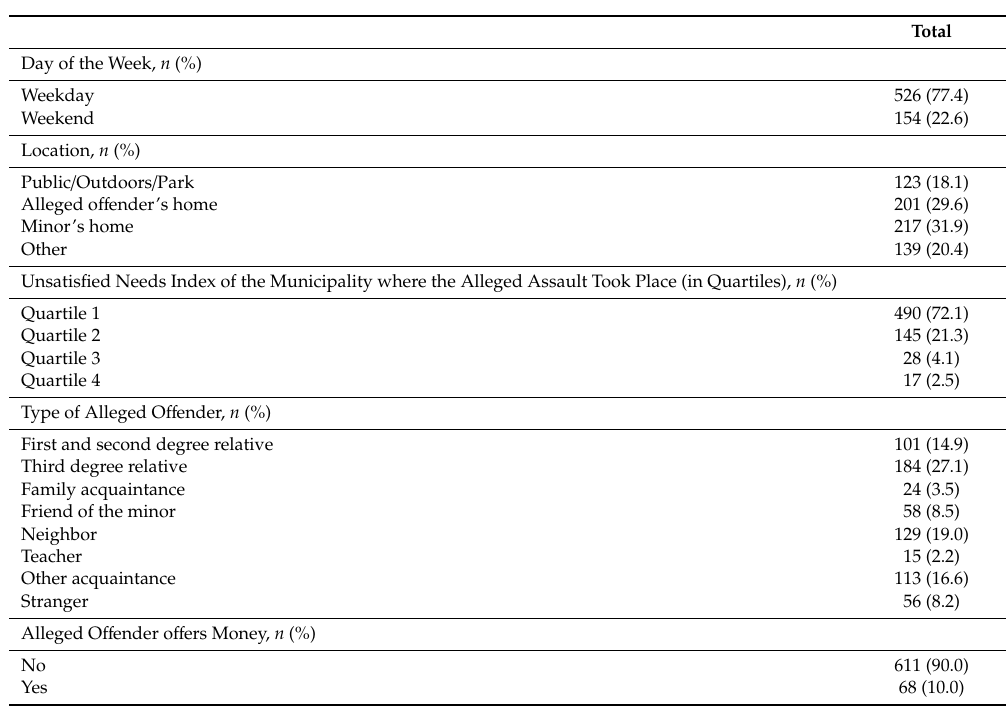
Table 2. Details of the alleged assaults ( N =